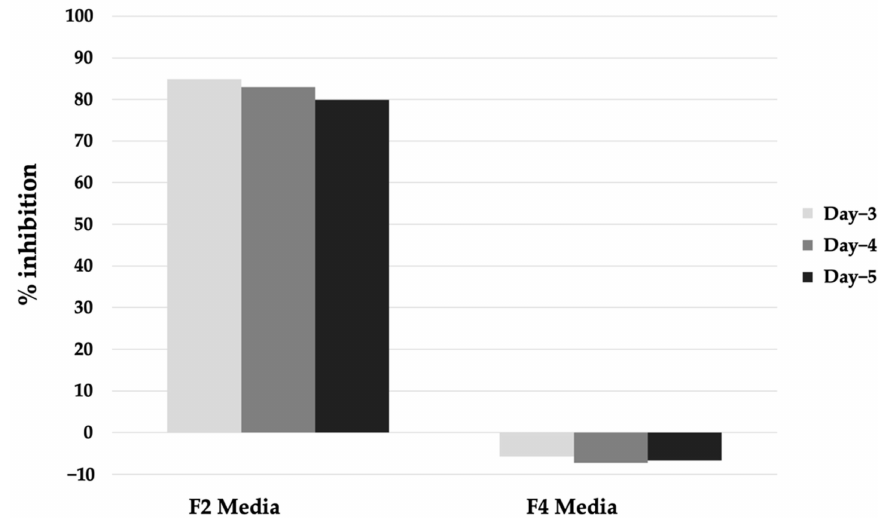
Figure 3. Inhibitory activity of extract of Aspergillus sp. BioMCC f.T.8501 cultured in F2 and F4 medium against